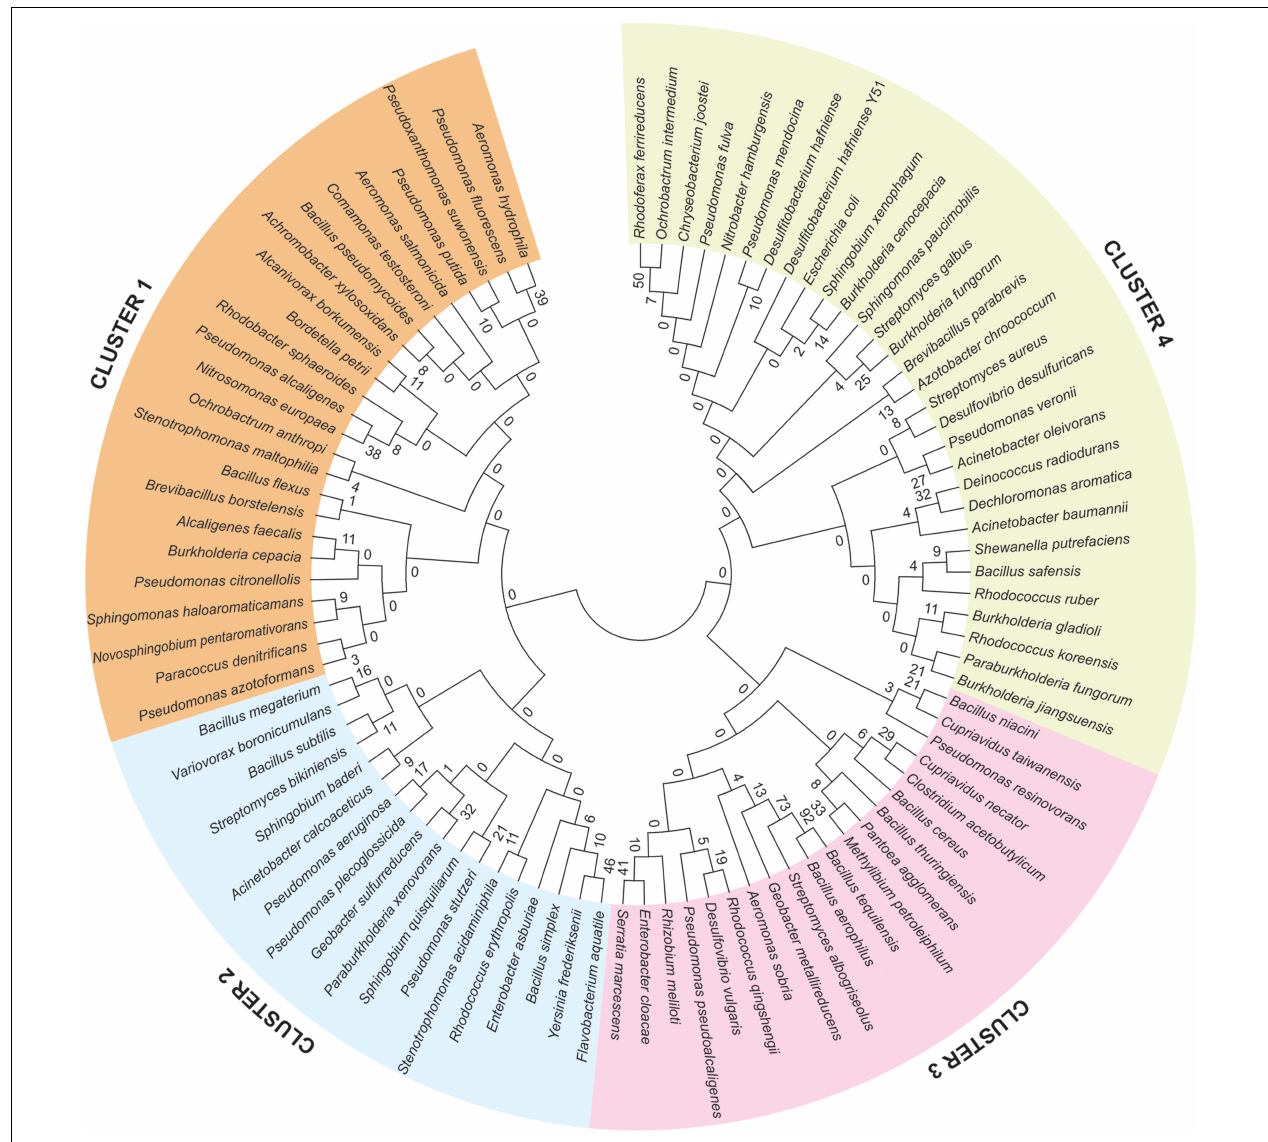
FIGURE 2 | Phylogenetic analysis of 92 identified genome of bioremediation bacterial species, derived from the sediments of the river Ganga and Yamuna. Phylogenetic cladogram clearly demarcated that, all the identified bacterial species shaped four different clusters represented in different colors and the bootstrap values are provided at the nodes of the phylogenetic